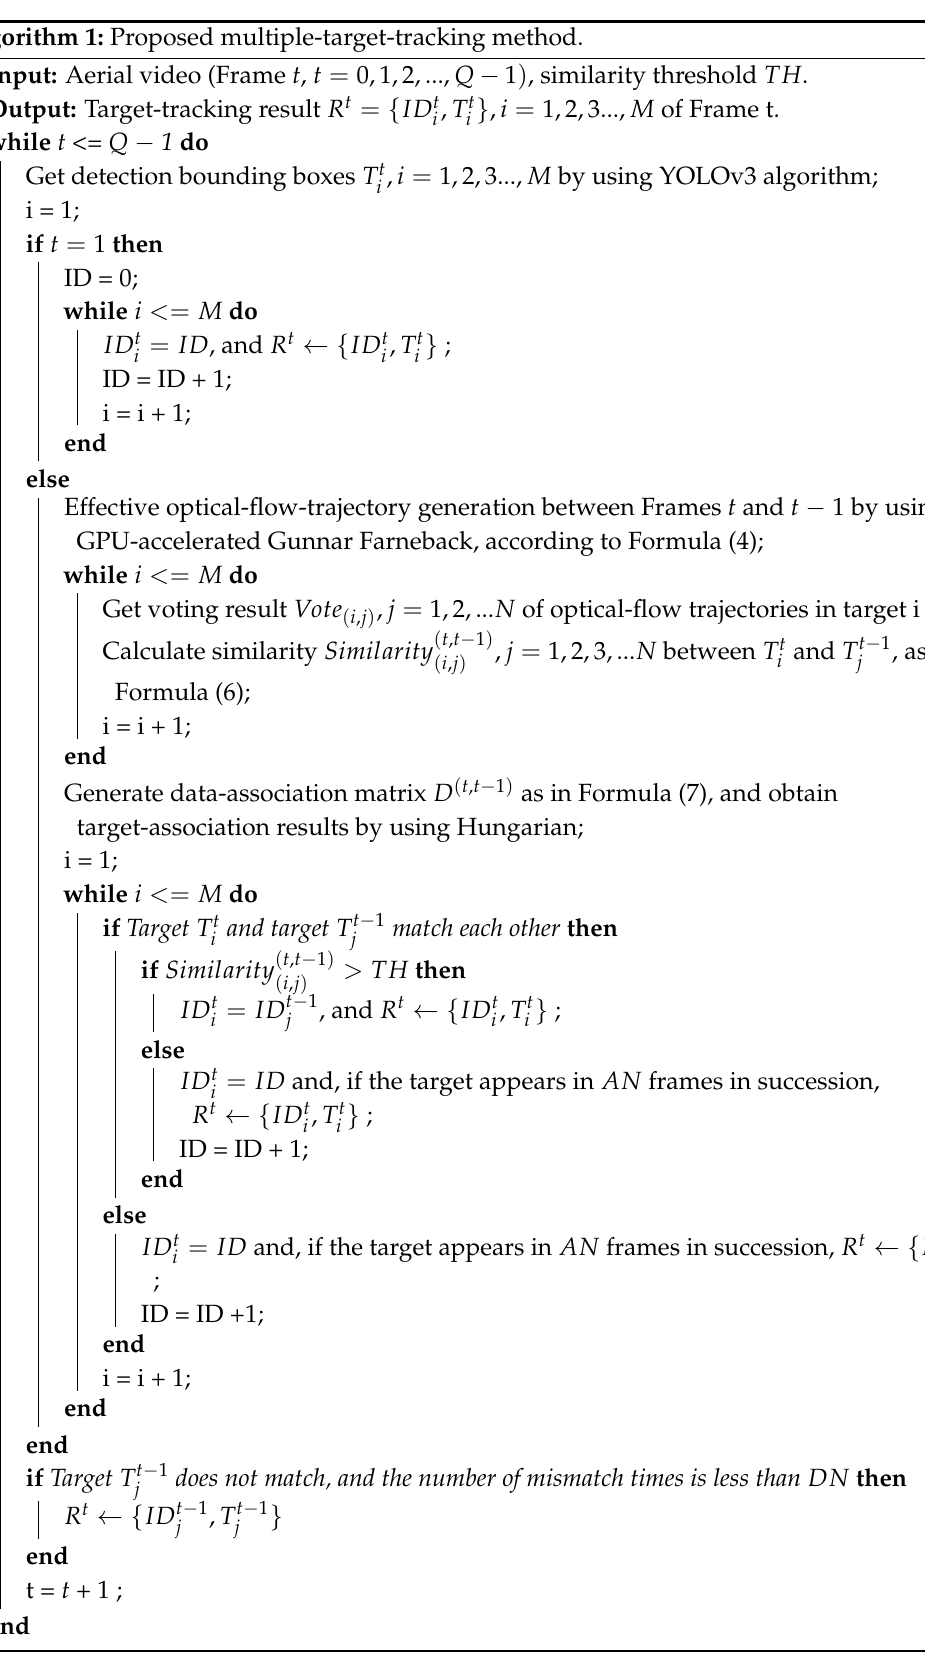
Algorithm 1: Proposed multiple-target-tracking